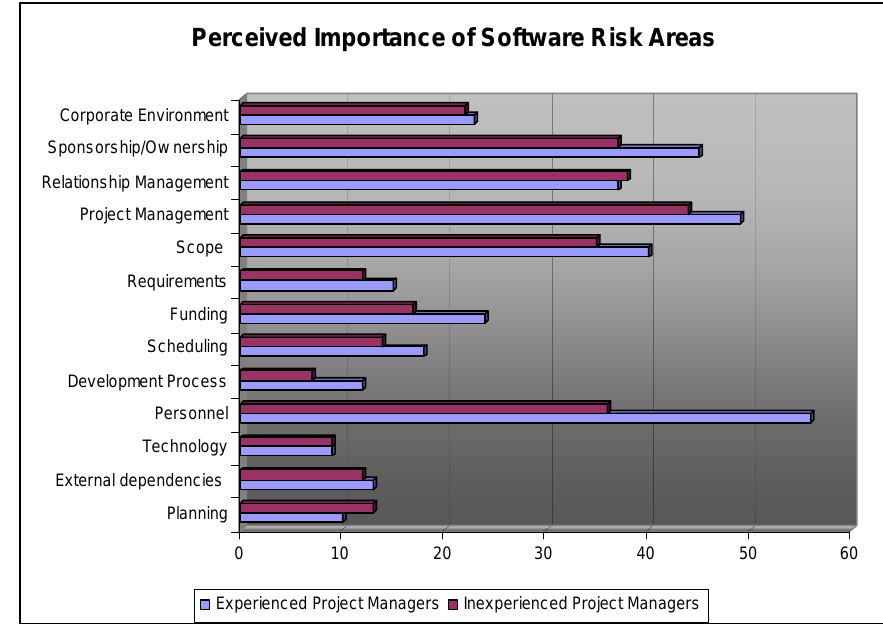
Figure 8: Perceived % importance of software risk areas